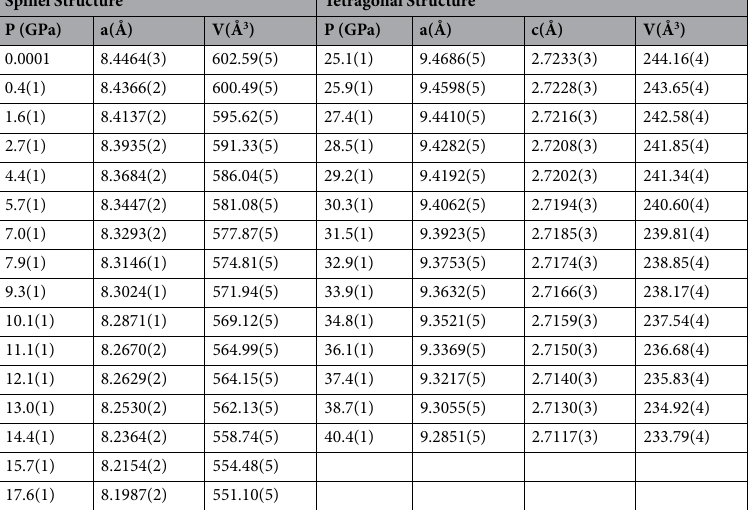
Spinel Structure